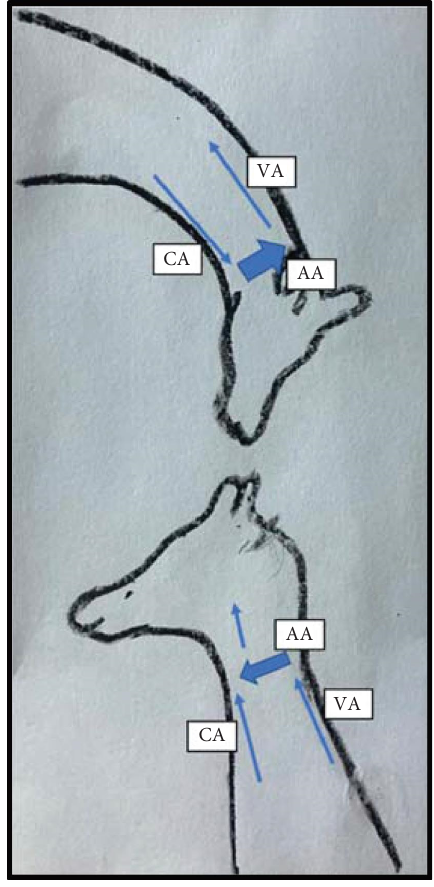
Figure 7: Diagrammatic presentation of the blood fow pattern through the anastomotic artery illustrating the shunting of blood towards or away from the brain depending on the position of the